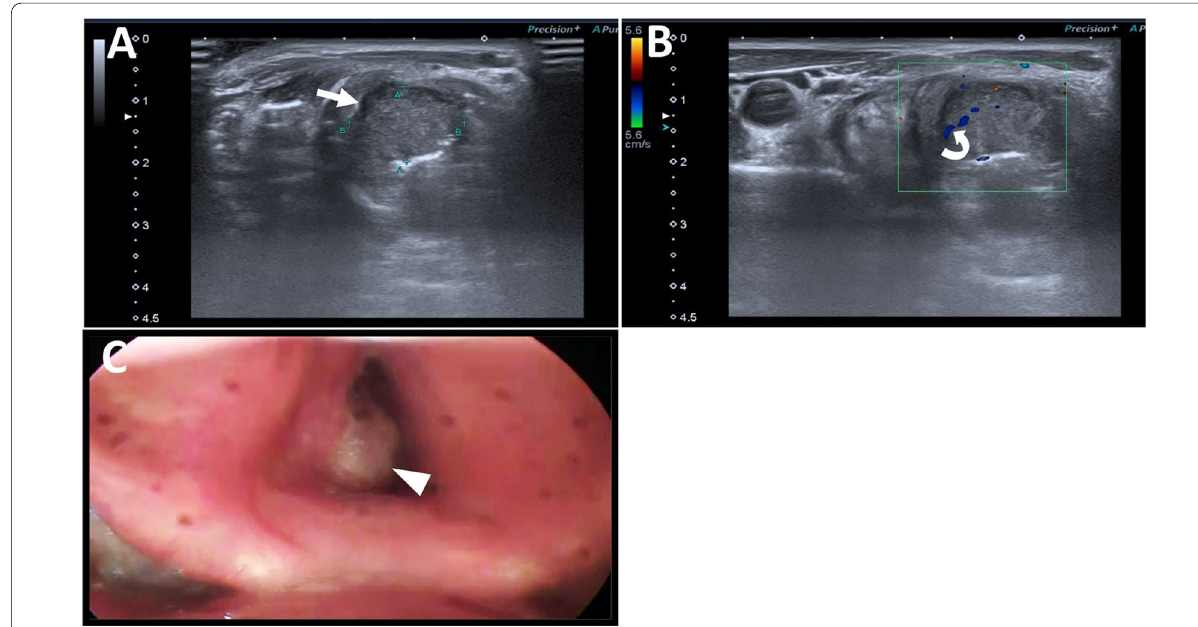
Fig. 4 A 73-year-old male heavy smoker presented with hoarseness of voice, dysphagia, and stridor. A Laryngeal ultrasound right lateral axial view with right thyroid cartilage (asterisk) as anatomical landmark, shows a large soft tissue isoechoic mass lesion (arrow) almost completely replacing the right VC with ill-defined lateral portion of the right thyroid cartilage, indicating invasion. No related cervical LNs were detected. B Colored Doppler sonographic images revealed that the lesion has an internal color signal (curved arrow) denoting its hypervascularity. C Flexible laryngoscopy of the same patient shows the lesion in the posterior part of the right vocal cord (arrow head). The anterior is at the bottom of this figure. The flexible laryngoscopy confirmed the sonographic findings, yet it is limited in estimation of the proper size and extension of the subglottic